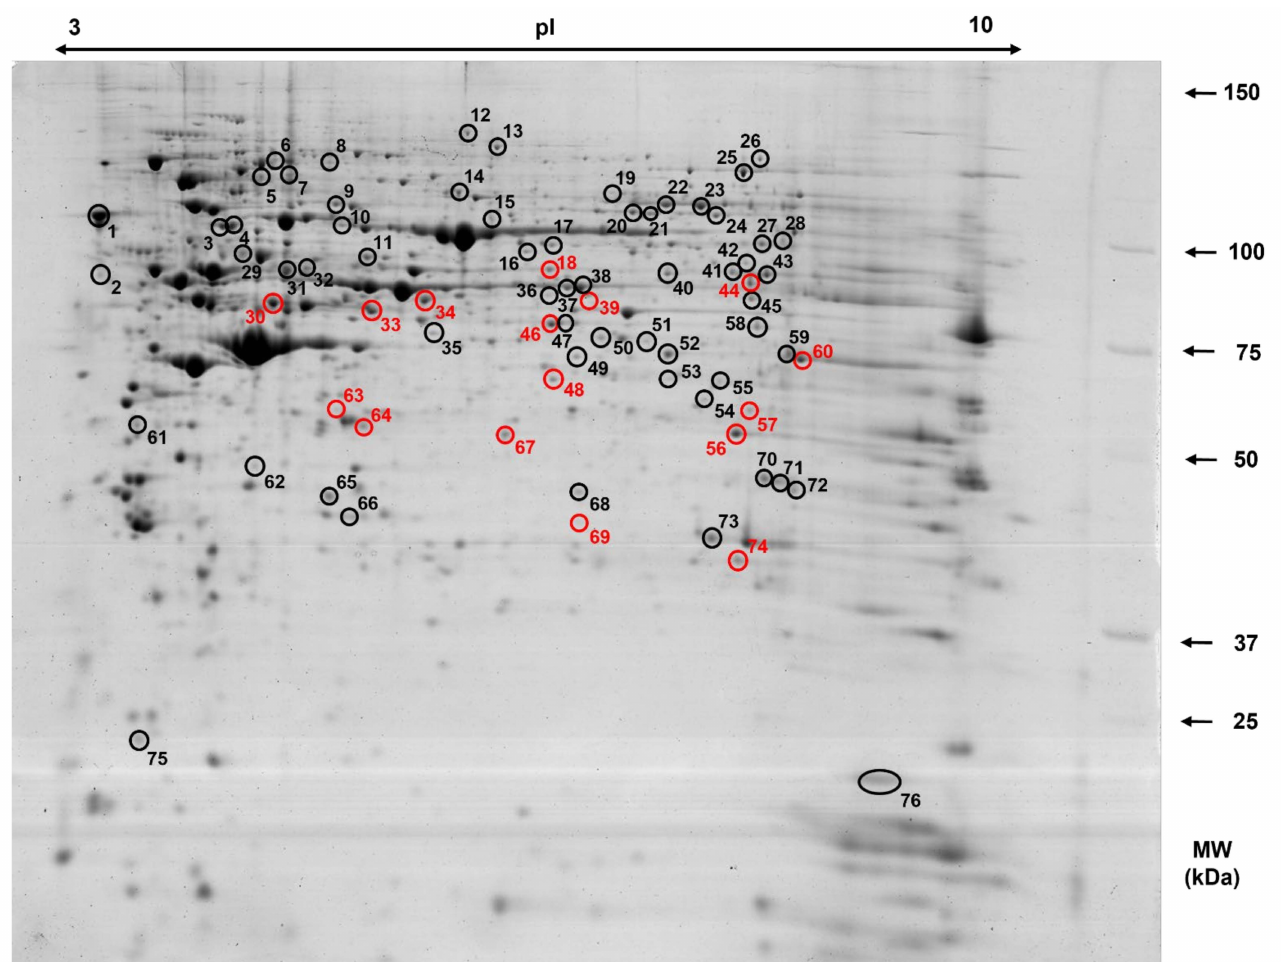
Figure 1. Representative 2-D gel image of cecal mucosa protein profile of 50-day-old piglets. Samples of 1000 µ g of protein were applied onto the IPG strip (24 cm, pH 3–10) for the first dimension; the second dimension was performed on 12% SDS-PAGE gels that were subsequently stained with Coomassie brilliant blue G-250. Numbered spots were identified using MALDI-TOF and MALDI FT-ICR MS after in-gel digestion of proteins by trypsin. The red circles indicate protein spots that were statistically altered in the cecal mucosa of nursery pigs fed a diet enriched with 4% of dried chicory root. The black circles along with the red ones indicate all identified spots that comprise 2-DE-based protein map of porcine cecal mucosa. Spot numbers correspond to those in Tables 4 and